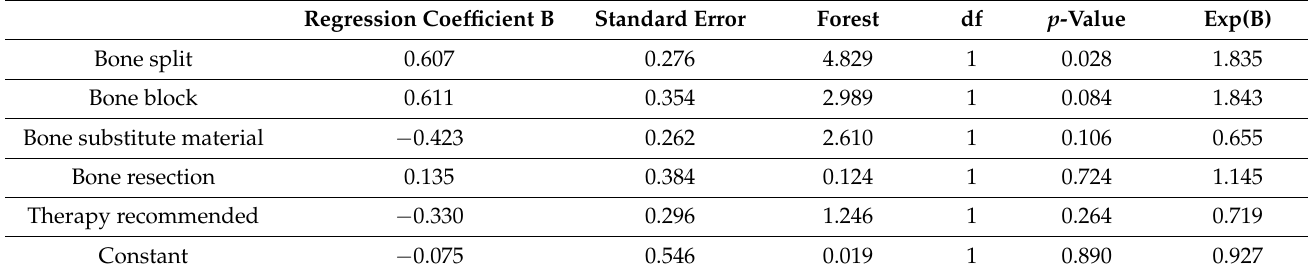
Table 6. Association between the dependent variable “previous radiotherapy” (yes vs. no) and the independent variables “bone split”, “bone block”, “bone substitute material”, “bone resection”, and “therapy recommended” for Case Vignette 2.